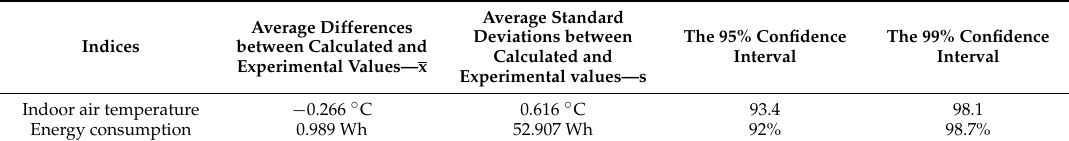
Table 2. Consistency verifications of model values and experimental results.